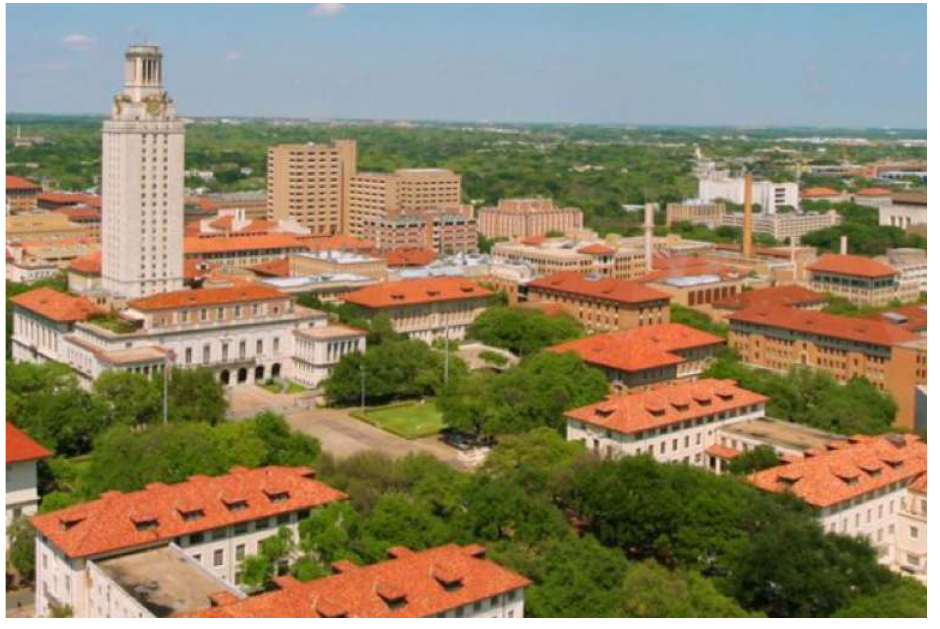
Figure 1: The University of Texas (UT) at Austin: Main campus with UT Tower